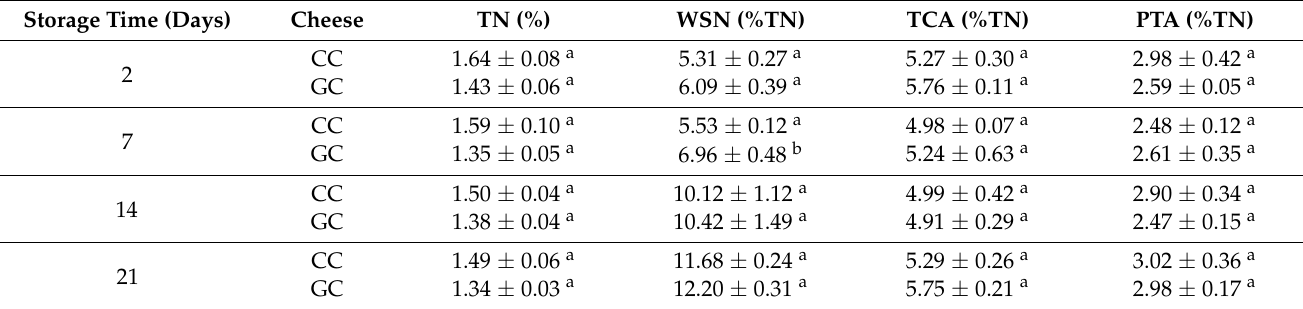
Table 4. Proteolysis of GC and CC fresh spreadable cheeses made from ovine